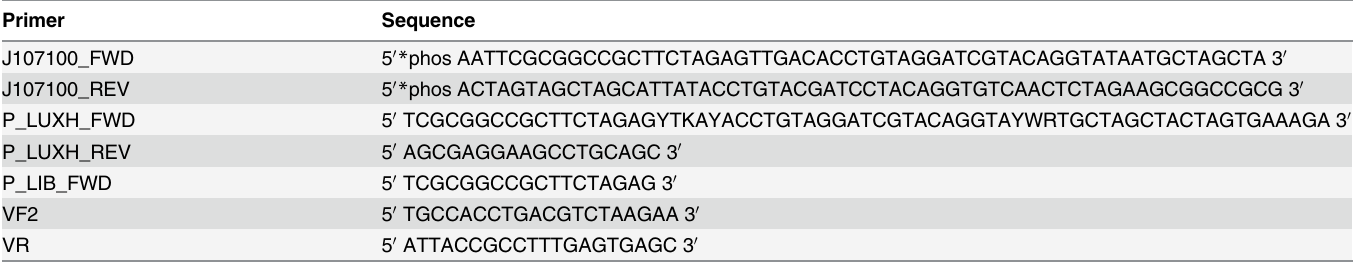
Table 2. A first PCR cycle was performed using the Phusion Hot Start Flex DNA Polymerase (New England Biolabs), according to the manufacturer ’ s protocol, on BBa_J23118 template with P_LUXH_FWD and P_LUXH_REV primers. The PCR cycles were programmed as fol- lows: i) 30 s at 98°C; ii) a temperature cycle sequence of 10 s at 98°C — 30 s at 52°C — 30 s at 72°C, repeated 5 times; iii) a temperature cycle sequence of 10 s at 98°C — 45 s at 72°C, repeated 30 times; iv) 10 min at 72°C. The PCR product was run on a 1% agarose gel and the correct band (908 bp) was extracted and purified (Extract II kit, Macherey-Nagel). This product was then used as a template for a second PCR reaction (3 min at 98°C; 10 s at 98°C — 30 s at 63°C — 30 s at 72°C, repeated 5 times; 10 min at 72°C) with P_LIB_FWD and P_LUXH_REV primers (see Table 2), to remove the annealing between heterologous strands of promoter sequences [40]. The resulting fragment was purified as before, XbaI/PstI-digested and ligated in the XbaI/PstI-digested pSB1A2 high-copy plasmid (ampicillin-resistant, with mutated pMB1 replication origin) and in the XbaI/PstI-digested pSB4C5 plasmid. The result- ing plasmids have an RFP expression device (identical to BBa_I13507) downstream of the pro- moter, with the non-BioBrick 'TACTAGTG' DNA junction between them. Table 2. List of oligonucleotides used to generate the library members and to sequence-verify all the plasmids. Primer